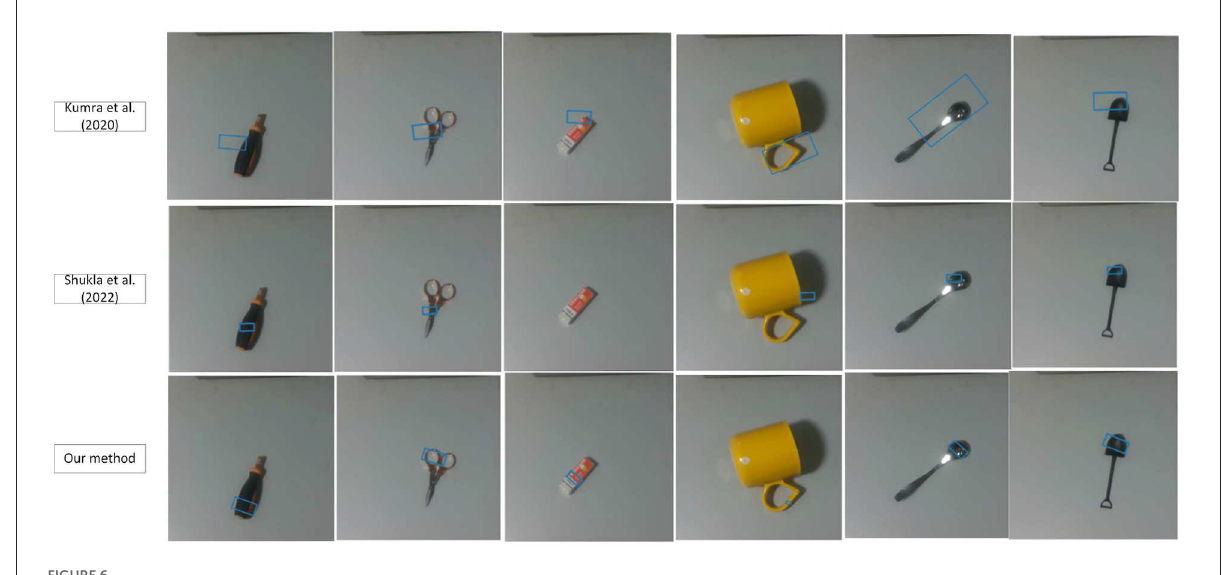
FIGURE6 Untrained single tool images.